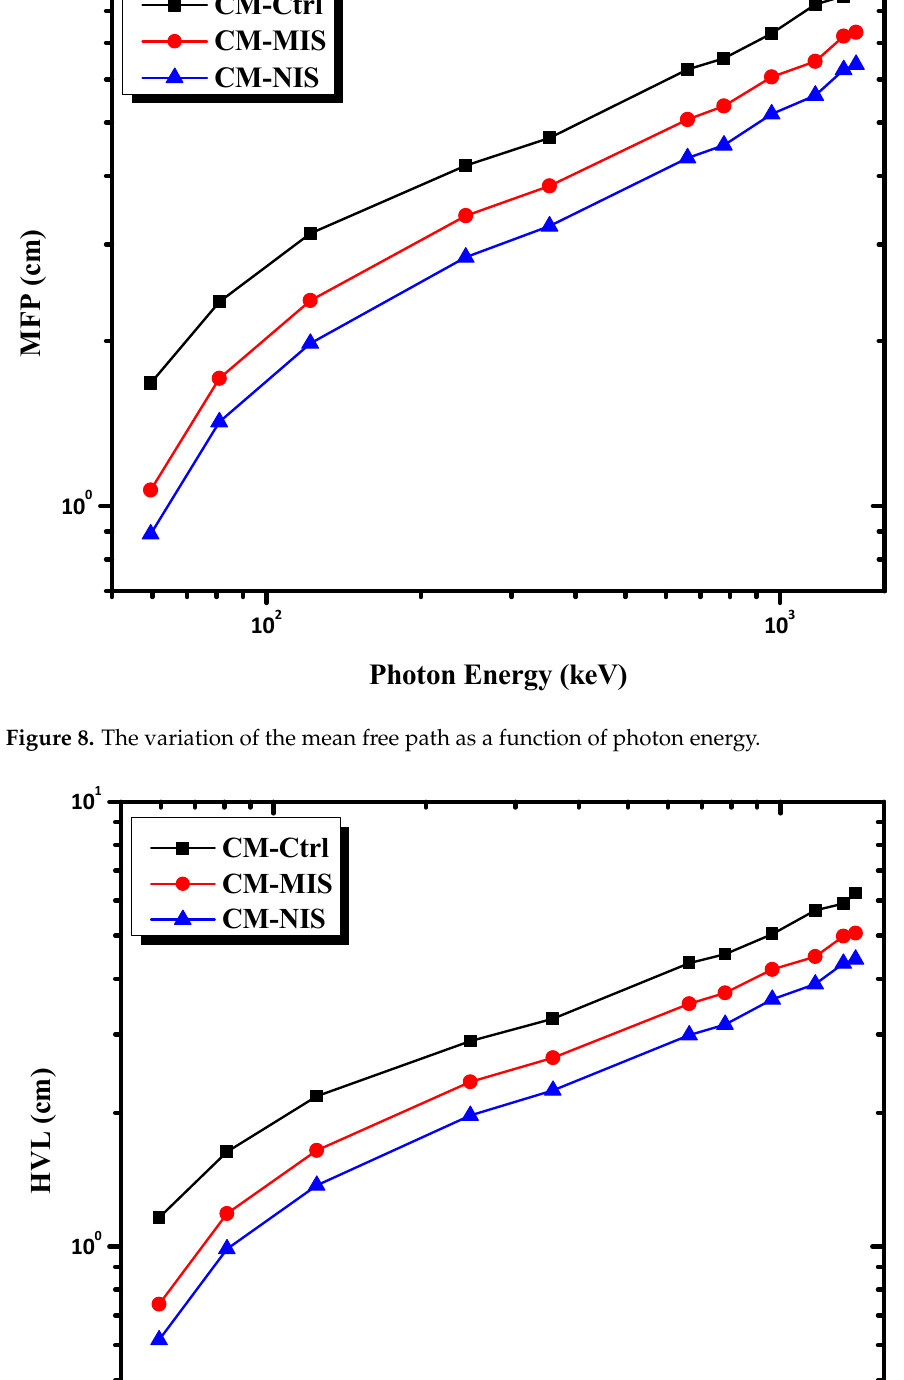
Figure 10. The variation of the TVL as a function of photon energy. 4. Conclusions In this research, innovative cement-mortar compositions based on waste marble and iron slag as aggregates were prepared to examine the radiation a tt enuation capability of these aggregates. Iron slag in the form of micro and nano sizes is utilized to study the